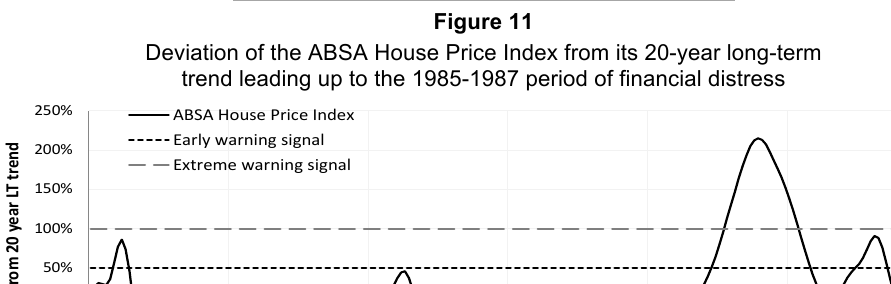
Deviation of the ABSA House Price Index from its 20-year long-term trend leading up to the 1985-1987 period of financial distress